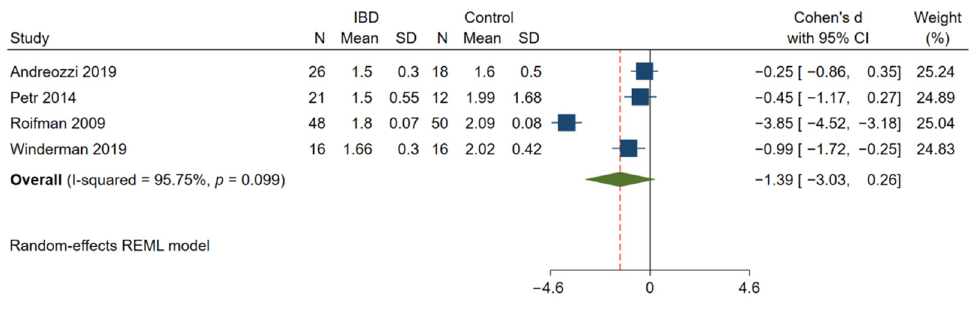
Figure 5. Meta-analysis of studies reporting on FMD in patients with IBD compared to matched controls. FMD, flow-mediated dilatation.